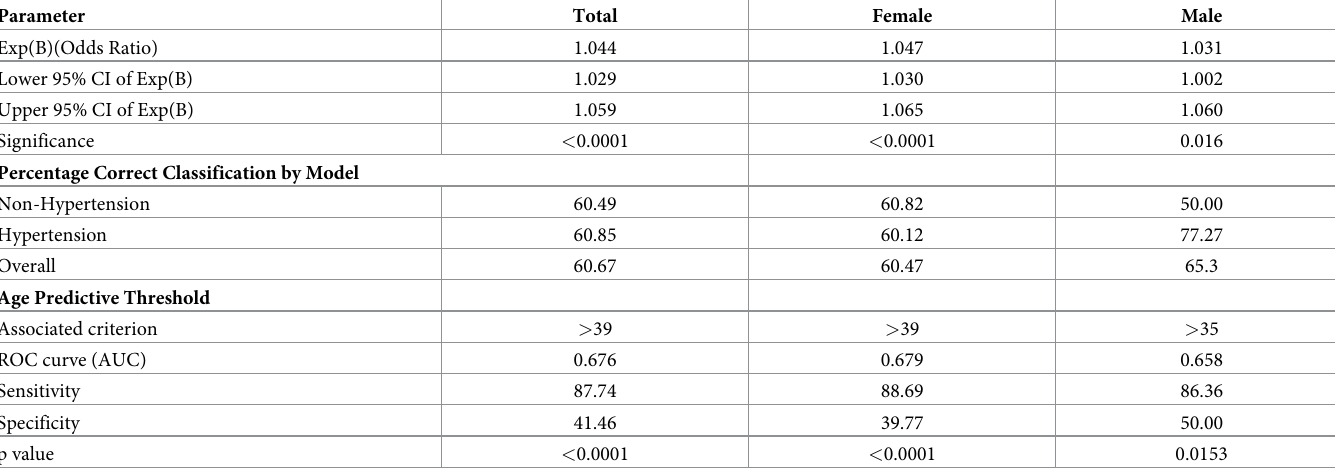
Table 5. Binary logistic age prediction of hypertension and critical age cutoff for hypertension among residents of Nyive. Parameter Total